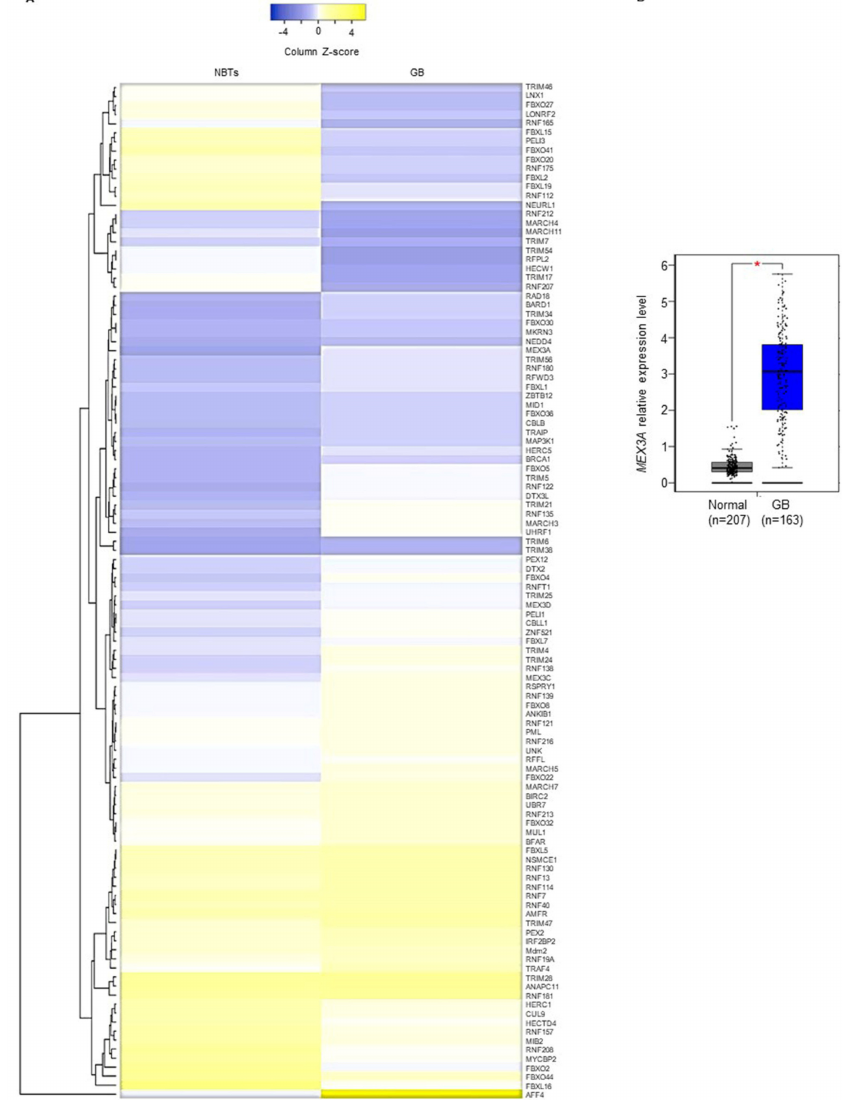
Figure 1. Gene expression profile of E3-ligases and F-box proteins in GB. ( A ) Heatmap shows a Z-score transformed gene expression values of catalytic E3-ligases and F-box proteins between normal